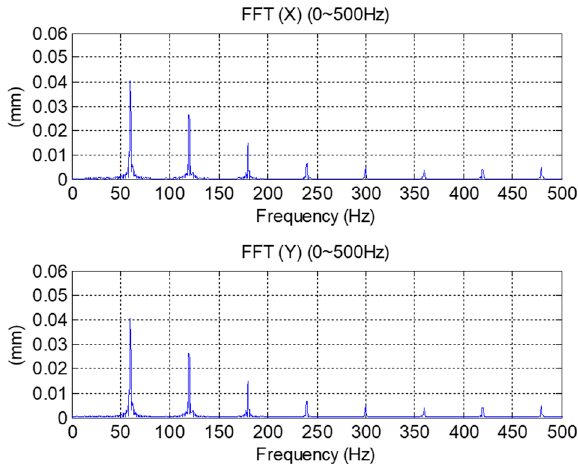
Figure 10. Using FFT to observe the original PSD output signals.